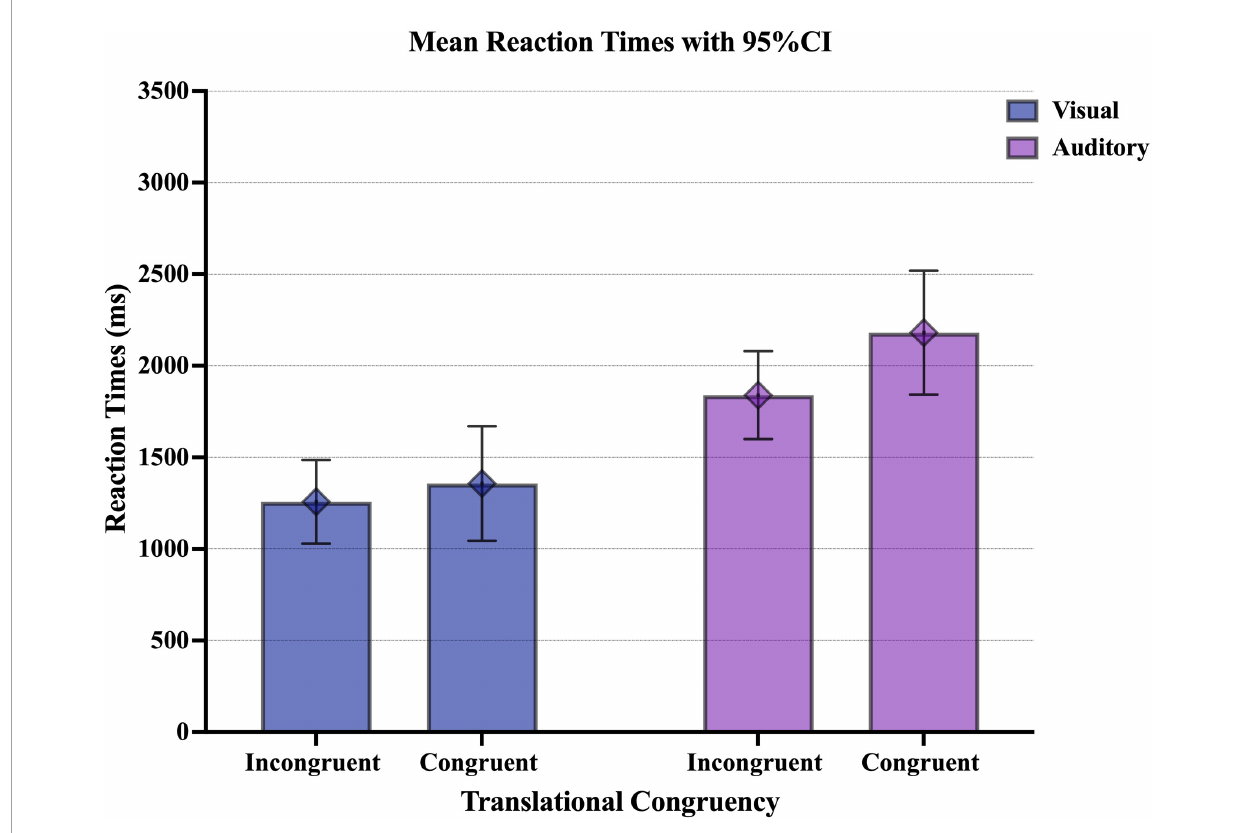
FIGURE4 Graph of the mean reaction times upon visual or auditory presentation of Japanese collocations with low semantic transparency and different translational congruency. The error bar shows the 95% CI.